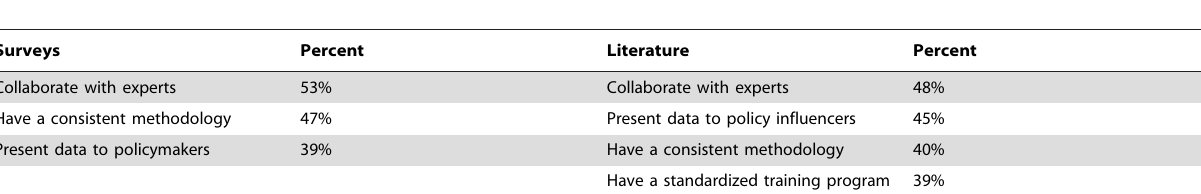
Table 2. Summary of the top recommendations from both the phone surveys and